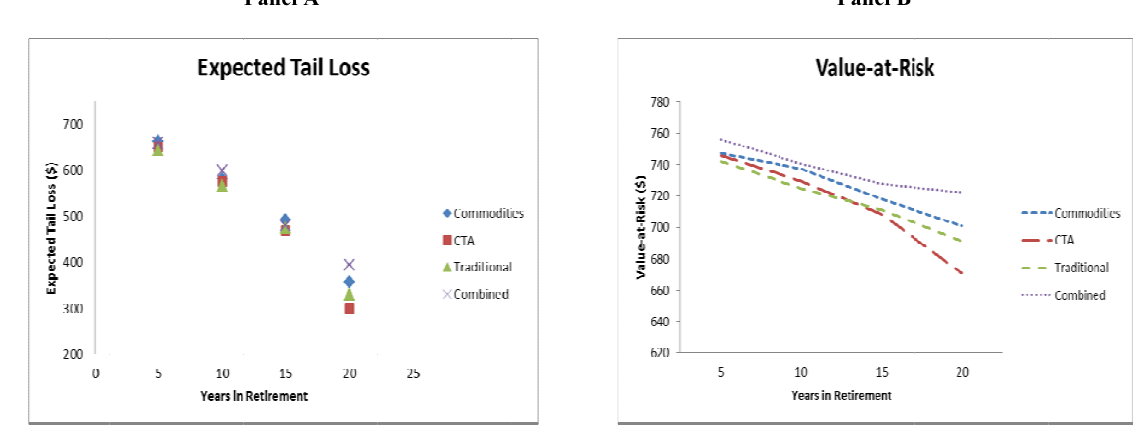
Figure 3 re Risk estima in the first 2 Value-at-Ri decrease wi VaR is high is lower b generating s of retireme becomes m